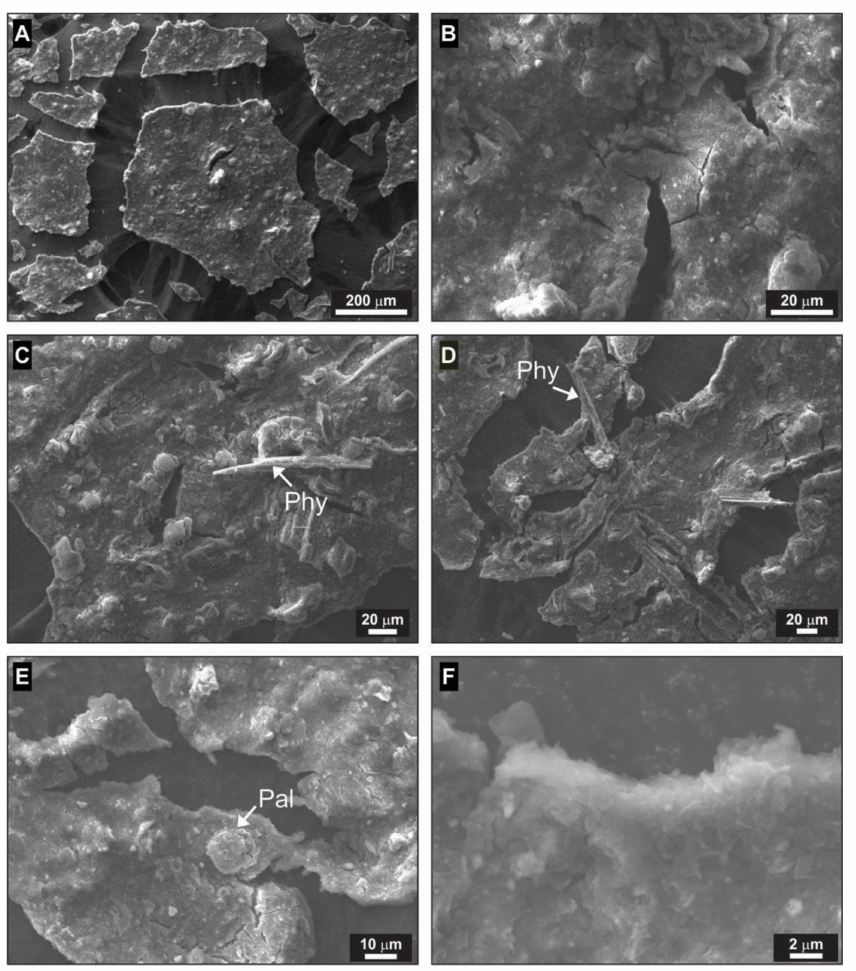
Figure 4. ( A – F ) Photomicrographs of solid bitumen taken by SEM. Phy: phytoclast; Pal: palynomorph. Following the identification of the bitumen in the isolated kerogen, a petrographic analysis (using reflected white and incident blue lights) was performed to assess the